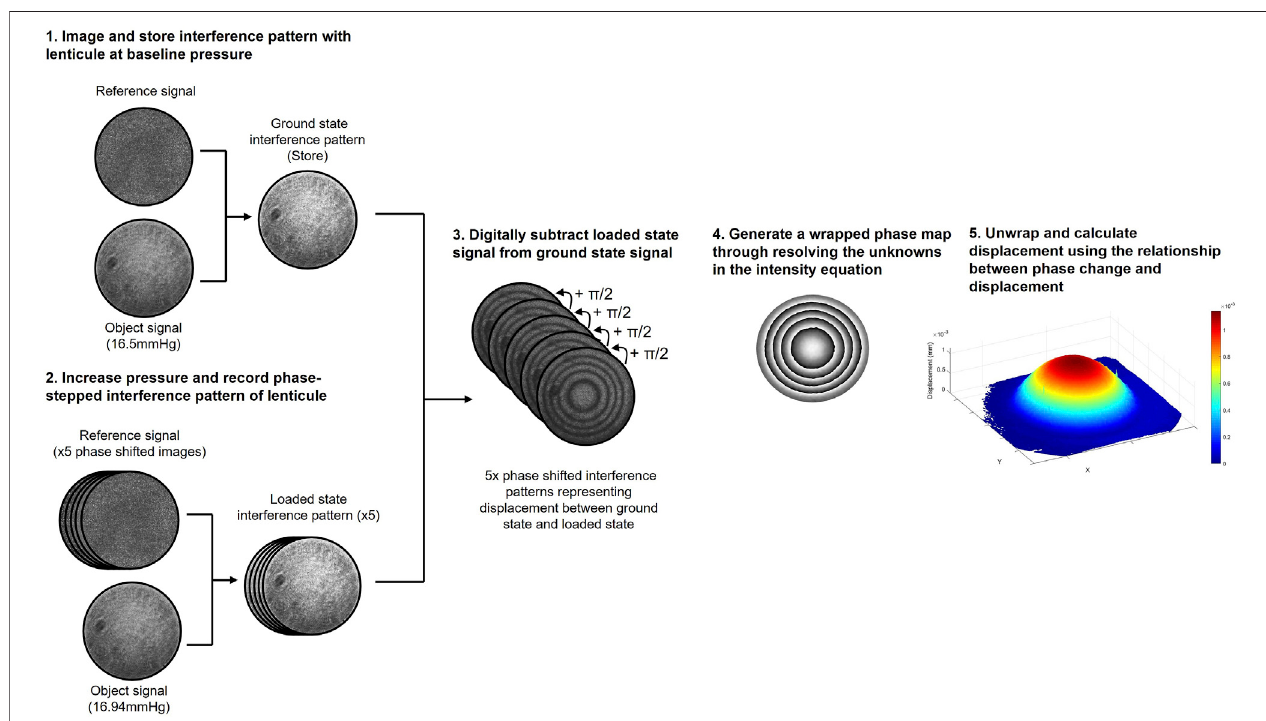
FIGURE 2 | Diagrammatic summary of the DSPI data acquisition and processing procedure used to measure axial